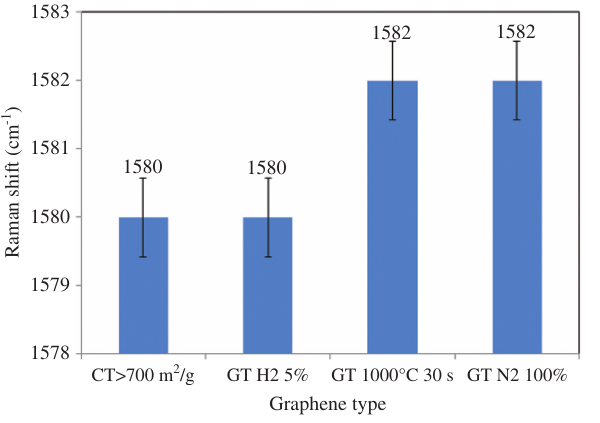
Figure 5 Raman spectra comparing the G peak position of gra- phene produced using four different